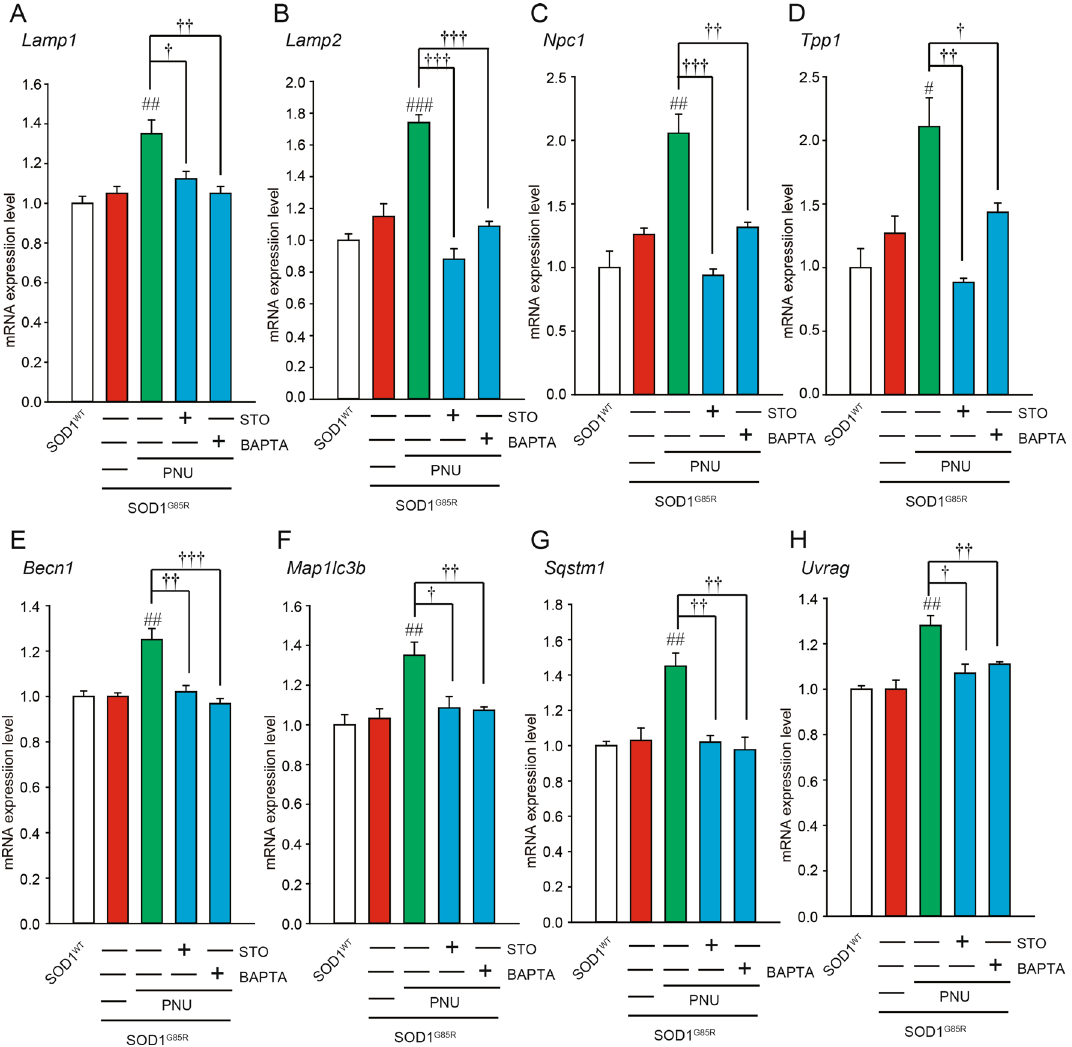
Figure 4. Effects of PNU282987 on transcription factor EB (TFEB) related mRNA expression. ( A – H ) N2a cells expressing mCherry-SOD1 G85R were treated with 1 µM PNU282987 (PNU) in the presence or absence of 1 µM STO609 (STO) and 1 µM BAPTA-AM (BAPTA) pretreated before 30 min. At 24 h after treatment with PNU, mRNA expressions of Lamp1 ( A ) , Lamp2 ( B ) , Npc1 ( C ) , Tpp1 ( D ) , Becn1 ( E ) , Map1lc3b ( F ) , Sqstm1 ( G ) , Uvrag ( H ) were analyzed using the SYBR Green-based RT-qPCR assay. The expression levels of mRNA were normalized to the expression levels of β-actin mRNA. Significance: # p < 0.05, ## p < 0.01, ### p < 0.01 vs. SOD1 G85R ; † p < 0.05, †† p < 0.01, ††† p < 0.01 vs SOD1 G85R with PNU282987 by One-way